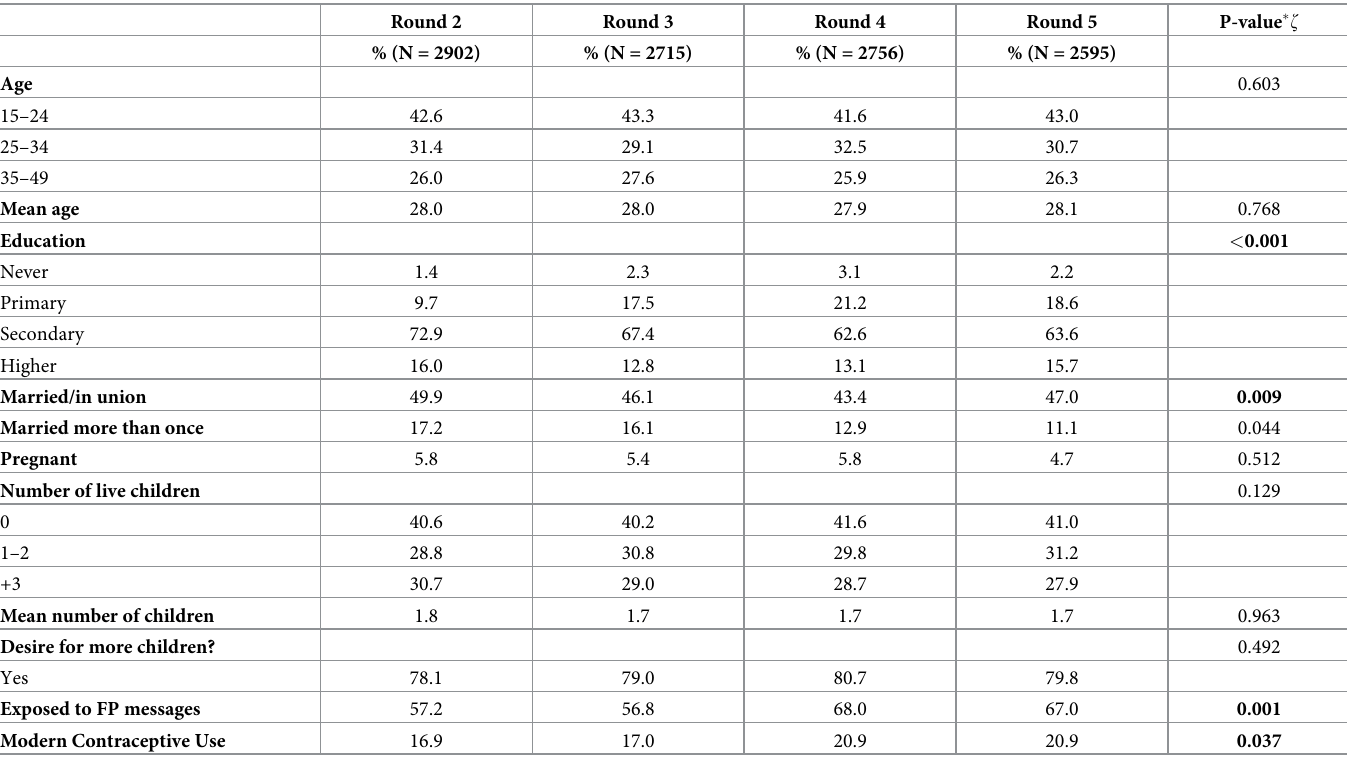
Table 2. Individual characteristics of women PMA 2020, 2014–2016, Kinshasa,